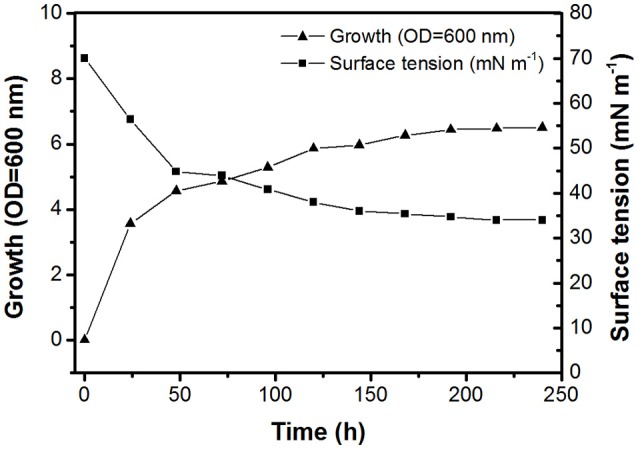
Time course of biosurfactant production, cell growth, and surface tension of R. fascians BD8 grown on mineral salt medium with 20 g L−1 n-hexadecane at 28°C.